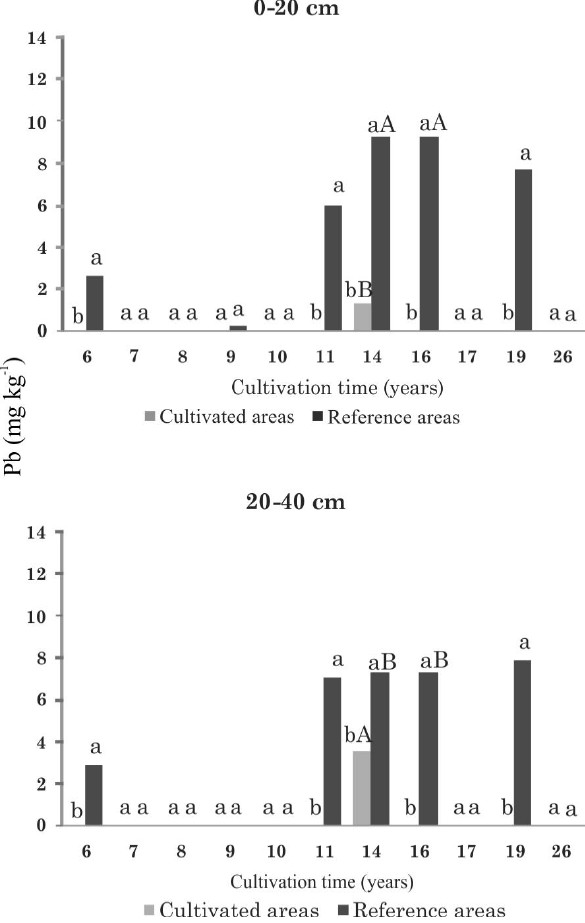
Figure 2. Total Ni contents in cultivated (CA) and reference areas (RA) in two layers (0-20 and 20- 40 cm) after different cultivation periods. Means followed by lowercase letters between environments (CA and RA) and capital letters between layers (0-20 and 20-40) did not differ statistically by Tukey’s test (p (cid:172)(cid:31)(cid:172) 0.05).